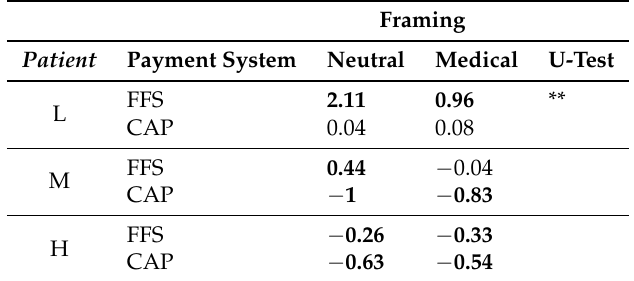
Table 9. Deviation from optimal treatment between Neutral and Medical Framing.